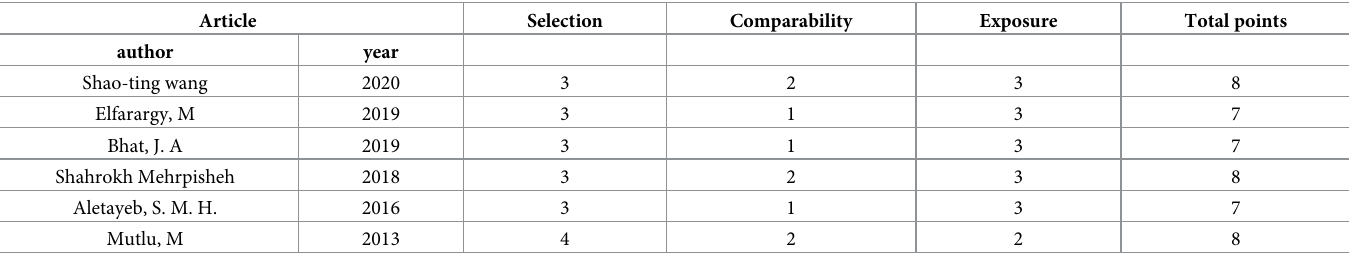
Table 2. Quality assessment of